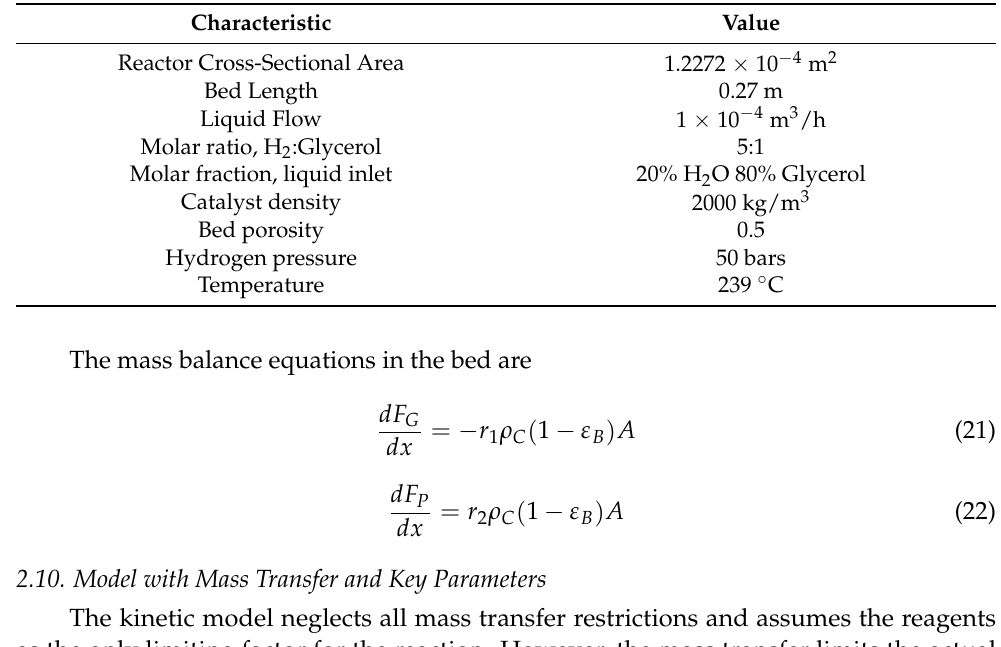
Table 3. Design features of the